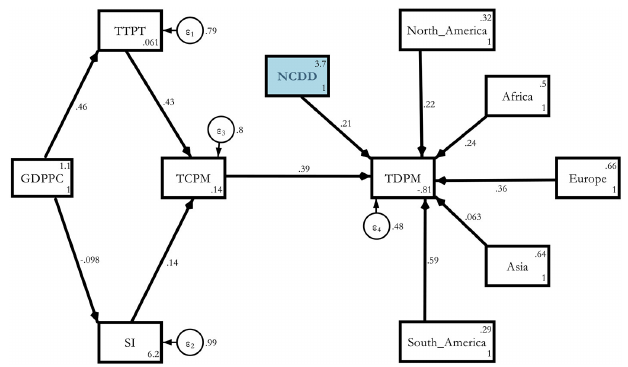
Model 3a. Estimated Determinants of COVID-19 deaths via NCDD with regional